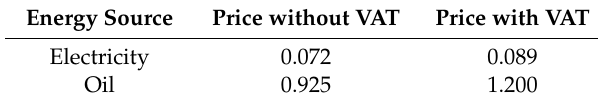
Table 8. Price of energy fuels ( € /KWh) with and without taxes